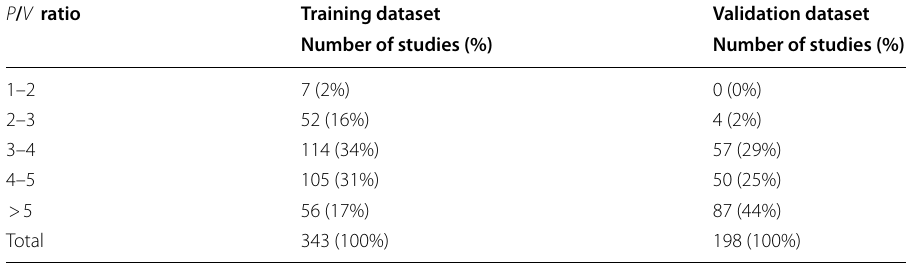
Table 3 P / V ratio values of the studies included in the training and validation datasets P / V